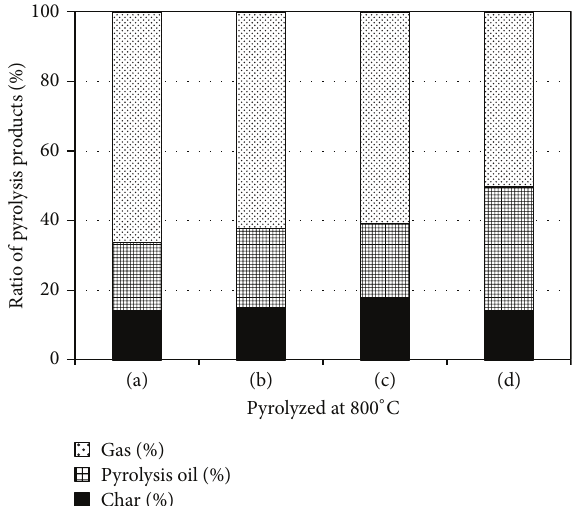
Figure 3: Product distribution of pyrolysis products obtained from Japanese cedar wood meal/catalyst (1: 1 w/w) mixtures pyrolyzed at 800 ∘ C: (a) Japanese cedar wood meal [10], (b) Wood meal/Fe 3 O 4 mixture, (c) Wood meal/TiO 2 mixture, and (d) Wood meal/ZSM-5 mixture.